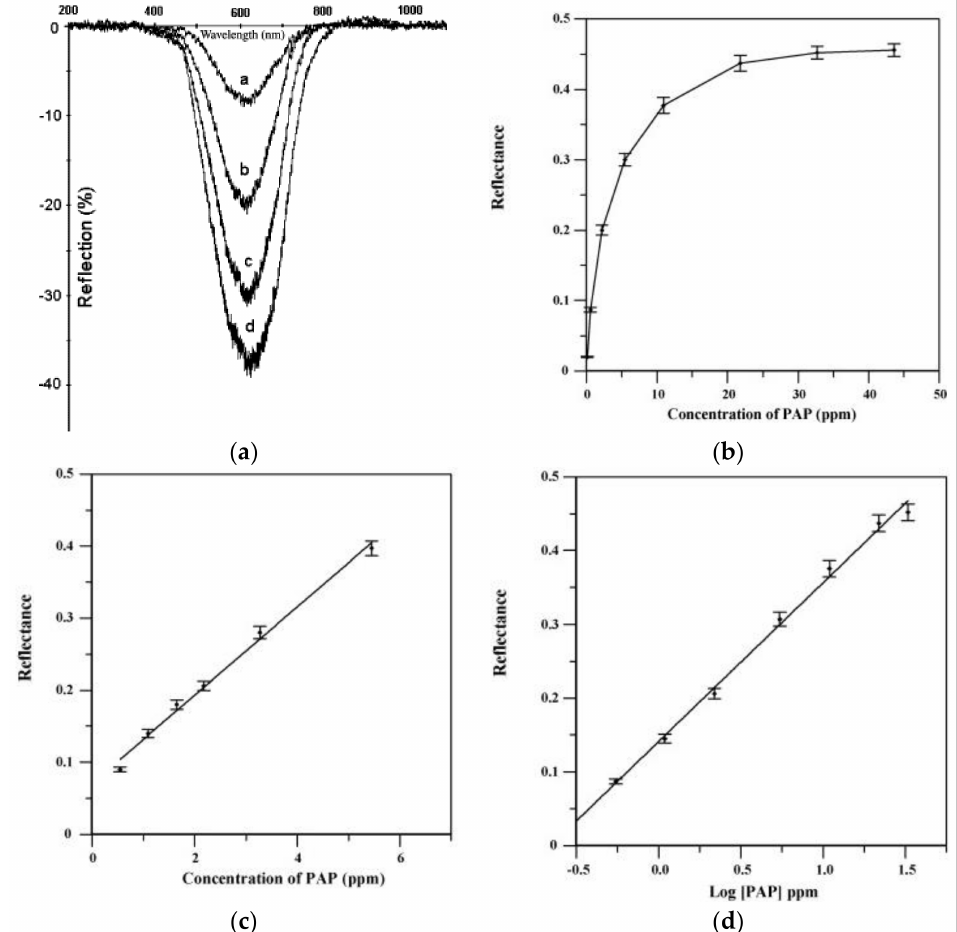
Figure 3. ( a ) Reflectance spectra of immobilized CAL4 before (Rf) and after (a–d) reaction with different concentrations of PAP, being 0.545 mg/L (curve a), 2.18 mg/L (curve b), 5.45 mg/L (curve c), and 10.9 mg/L (curve d). ( b ) Response curve to a wide range of PAP concentrations. The panels ( c , d ) show the linear and non-linear portions of the response curve. (Reprinted-adapted-with permission from